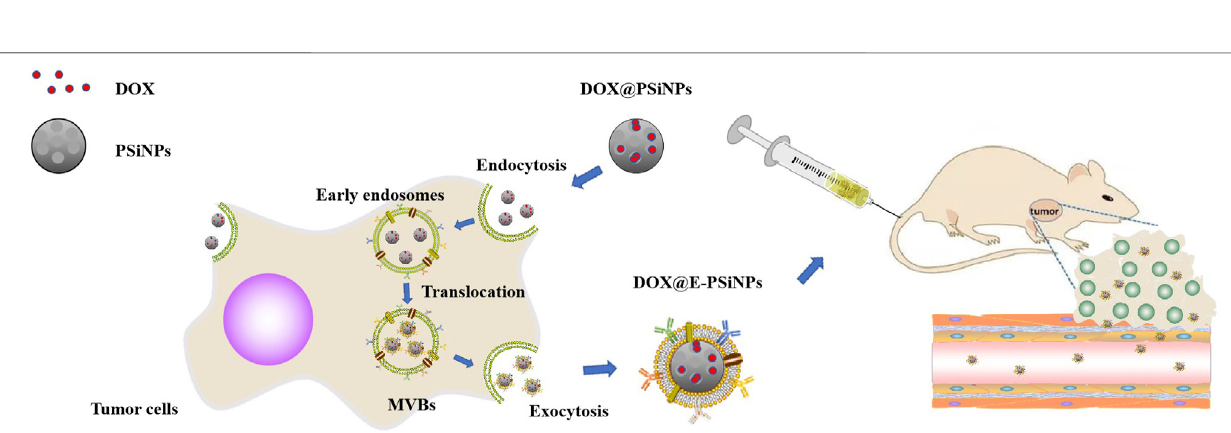
Frontiers in Pharmacology |